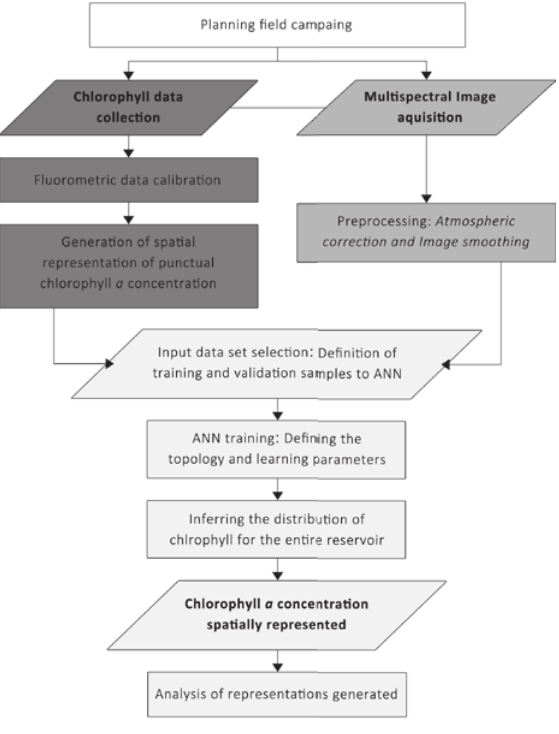
Figure 1 - Experimental design. ANN: Artifi cial Neural